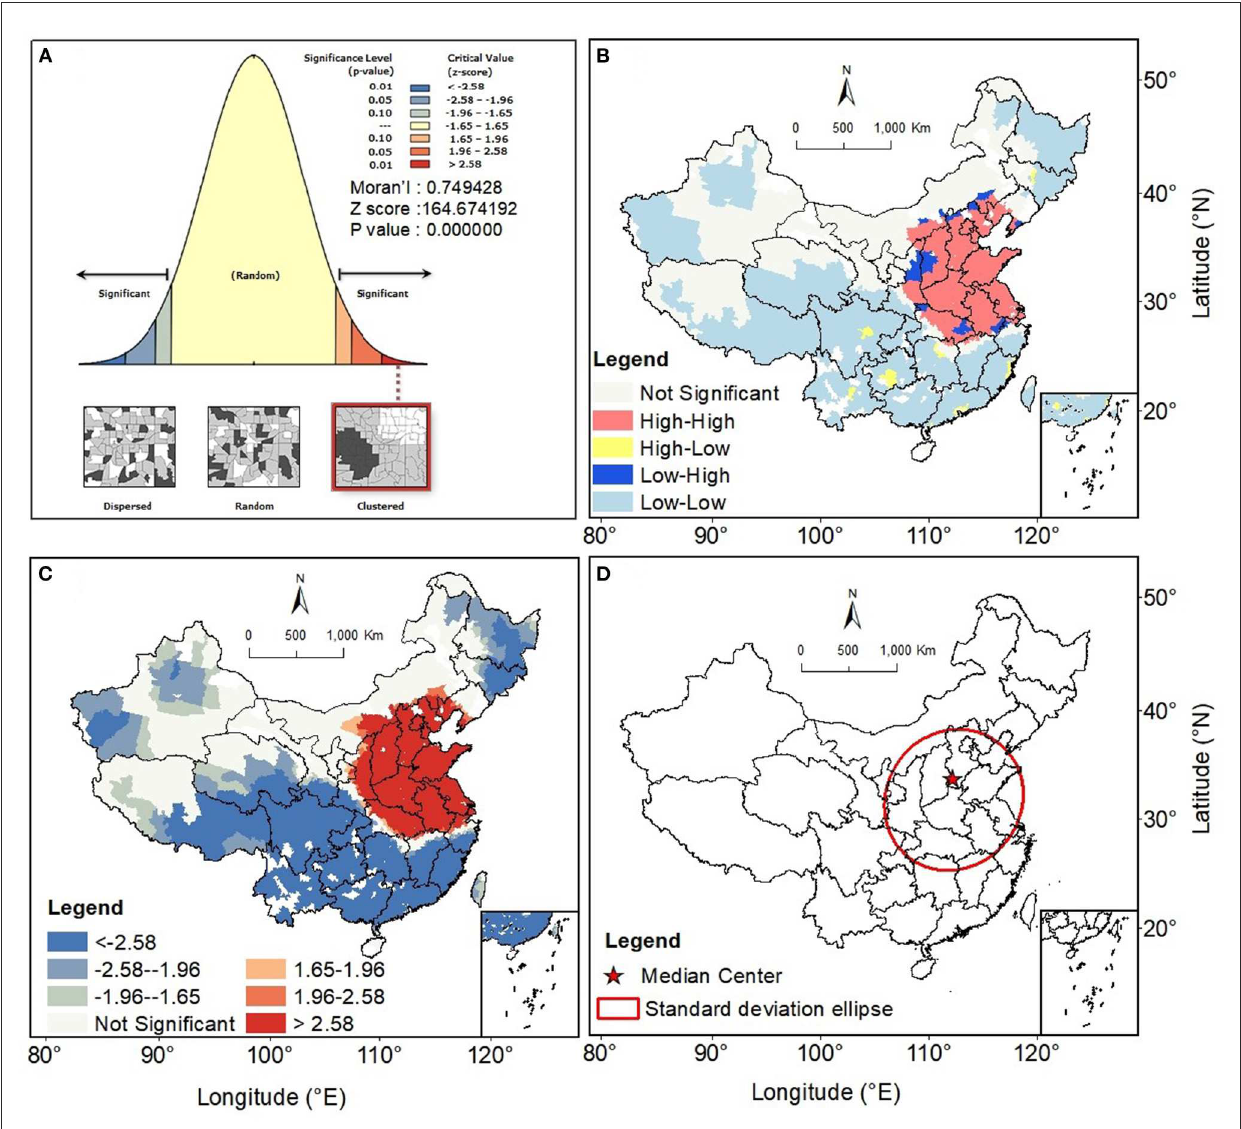
FIGURE4 Spatial clustering characteristics of the rate of change of O 3 concentration in county-level units in China, 2013–2018. (A) Global spatial autocorrelation test results; (B) Spatial distribution of the spatial clustering of O 3 concentration variation rates; (C) Spatial distribution of cold and hot spots for the rate of change of O 3 concentration, in the cold and hot spot analysis we used Getis Ord Gi* analysis to calculate Z scores, where | Z scores| > 1.65 corresponds to p < 0.10, | Z scores| > 1.96 corresponds to p < 0.05, | Z scores| > 2.58 corresponds to p < 0.01. Z scores are negative indicating a cold spot, and a positive Z score indicates a hot spot; (D) Spatial distribution of the standard ellipse of the rate of variation of surface O 3 concentration and the center of change in China from 2013 to 2018.